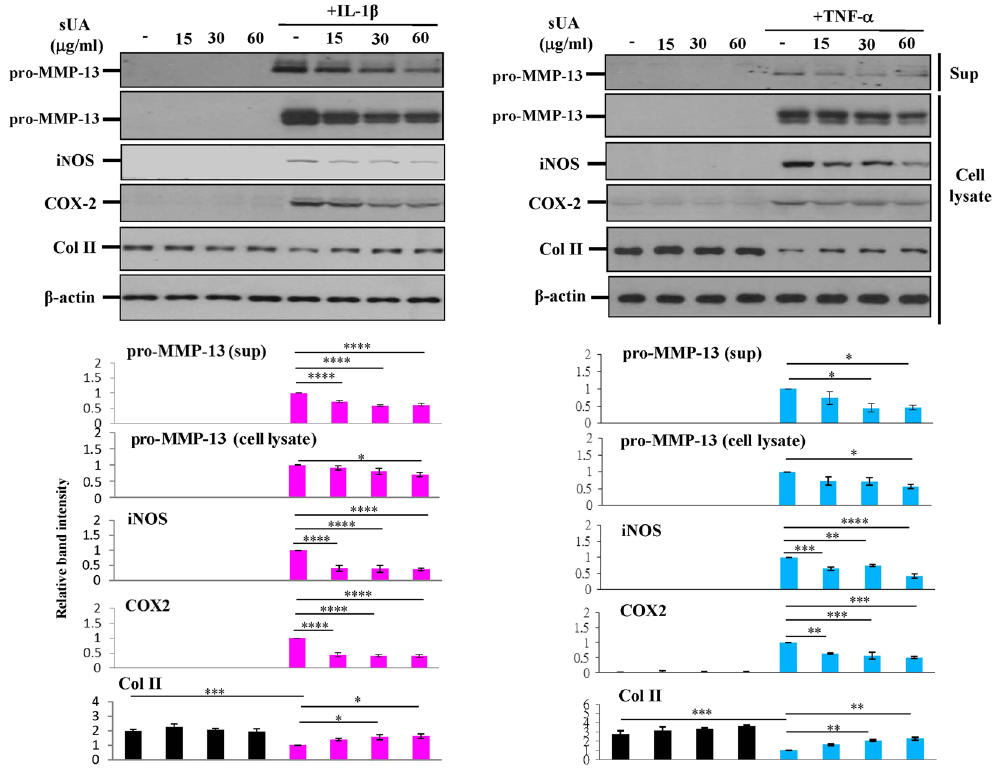
Figure 1. Effects of sUA on IL-1 β - and TNF- α -stimulated chondrocytes. Chondrocytes (3 × 10 6 ) were pretreated with different concentrations of sUA for 72 h and then stimulated with IL-1 β or TNF- α for another 24 h. iNOS, COX-2, Col II, pro-MMP-13 (both in the supernatant [Sup] and in the cell lysate), and β -actin expression levels were determined by western blotting. The cropped blots are displayed and full-length blots are shown in the Supplementary Figure 7. The results are from at least 3 independent experiments. * p < 0.05; ** p < 0.01; *** p < 0.001; **** p <